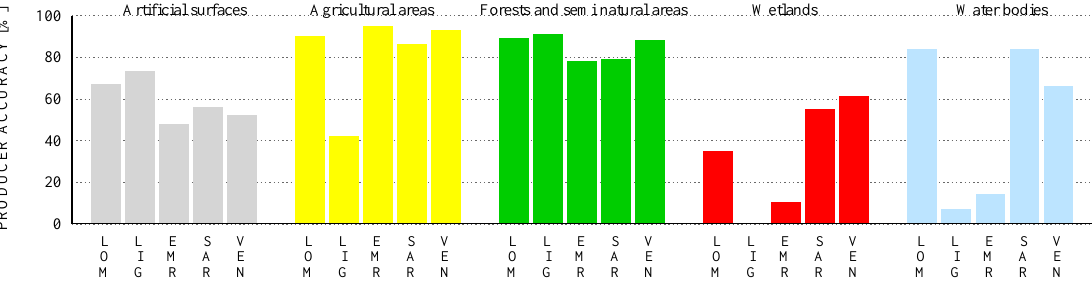
Figure 14. Comparison between GlobeLand30 2010 and Italian regional datasets (I reclassification, no buffer case): user accuracies for each class and dataset.